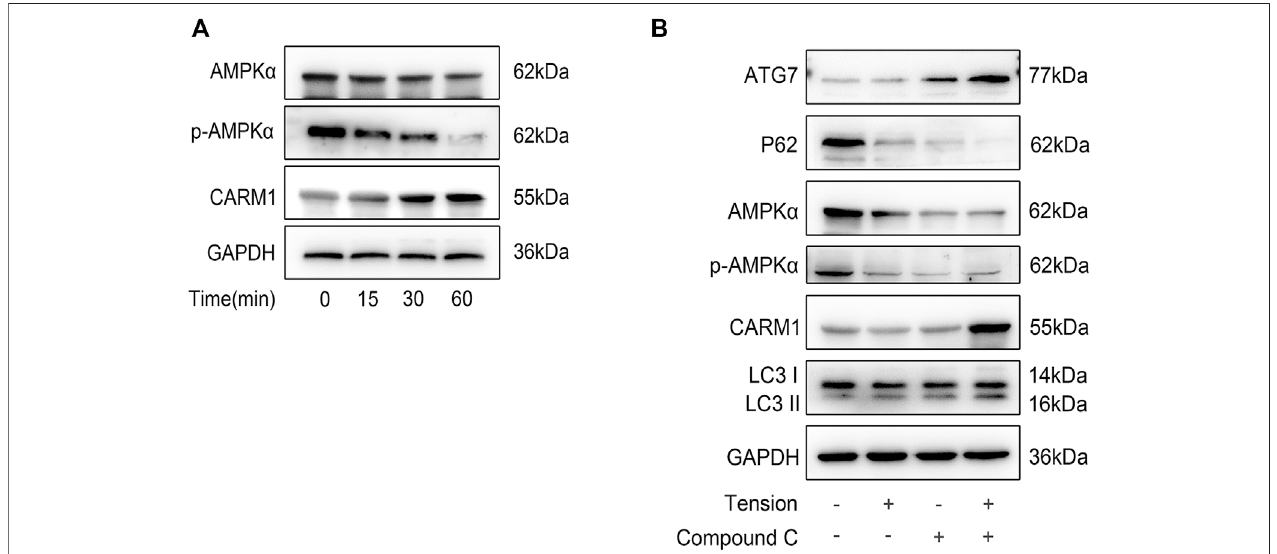
FIGURE6| MechanicaltensiontiggersMLO-Y4autophagy via AMPKsignaling. (A) TheexpressionofthesignalingmoleculesasAMPL α ,p-AMPK α ,CARM1were detectedbywesternblot. (B) WesternblotanalysisofAMPL α ,p-AMPK α ,CARM1ATG7,P62,andLC3BinMLO-Y4afterthetreatmentoftension,compoundCorboth. All cell experiments were repeated 3 time and each time they were performed in at least 3 replicated